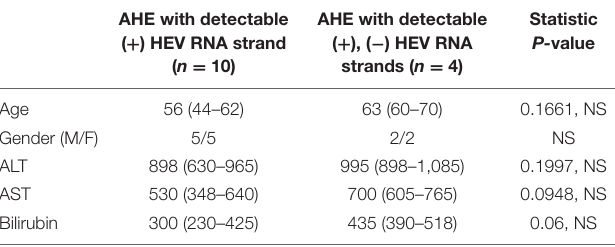
persistence and/or replication in the PBMCs. AHE with detectable ( + ) HEV RNA